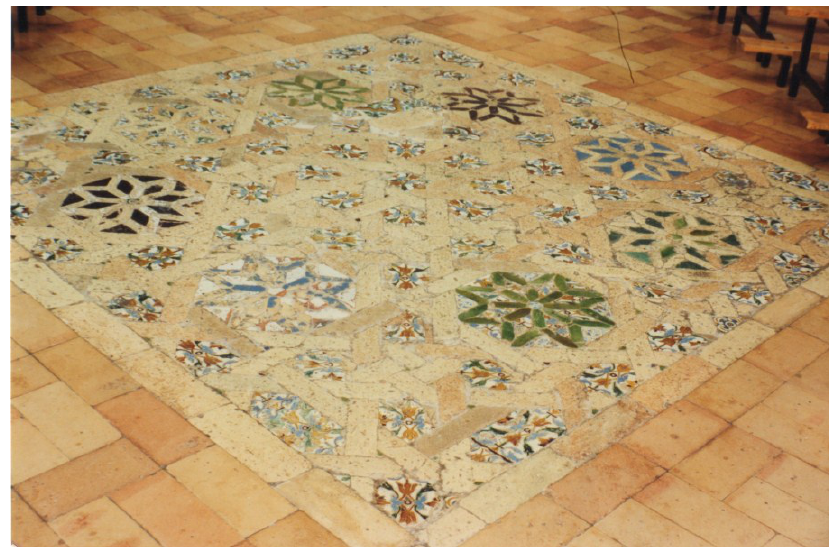
Figure 14. Portal. Madre de Dios Convent. Baena (Cordoba ). Photo took by author.